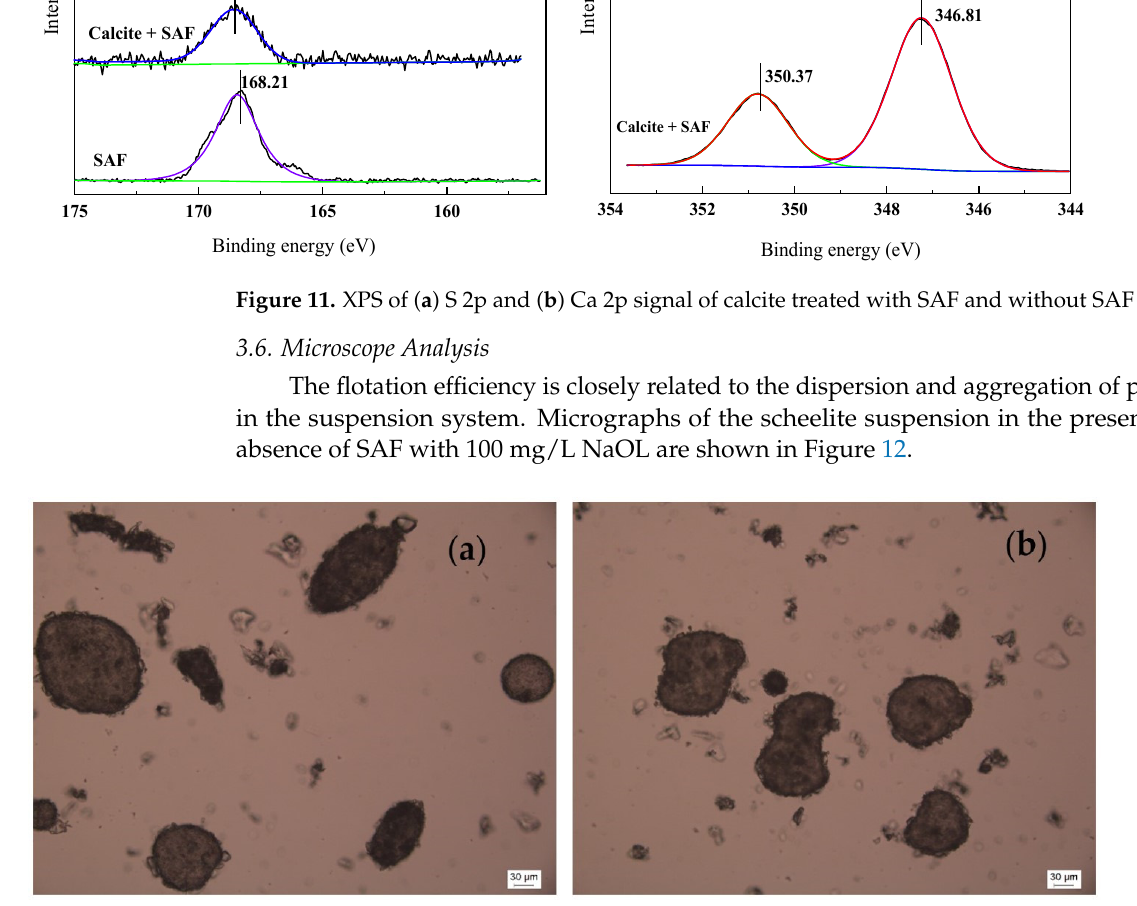
Figure 12. Micrographs of the scheelite suspension in the presence and absence of SAF at pH 9. ( a ) scheelite + 100 mg/L NaOL, ( b ) scheelite + 200 mg/L SAF + 100 mg/L